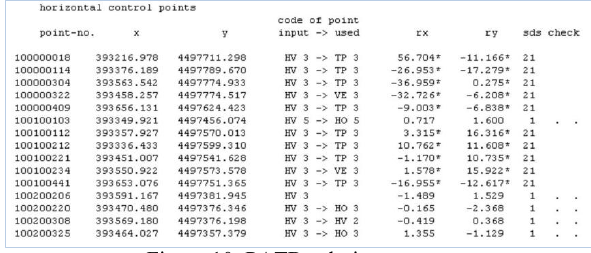
Figure 10. PATB solution report